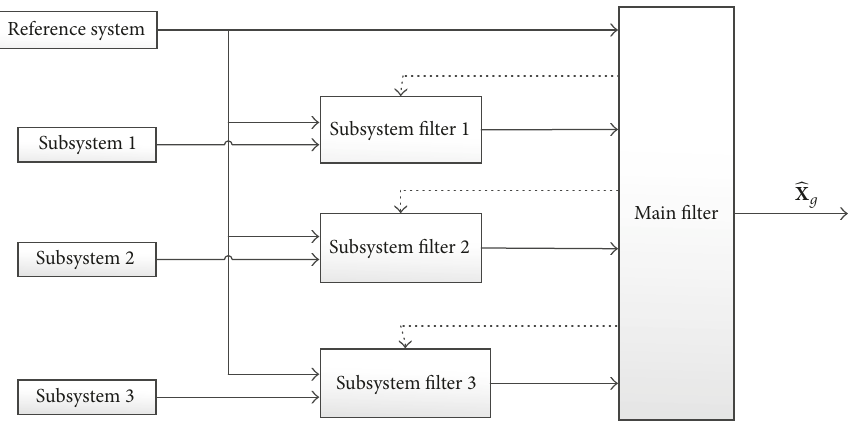
Figure 1: The structure of the federal